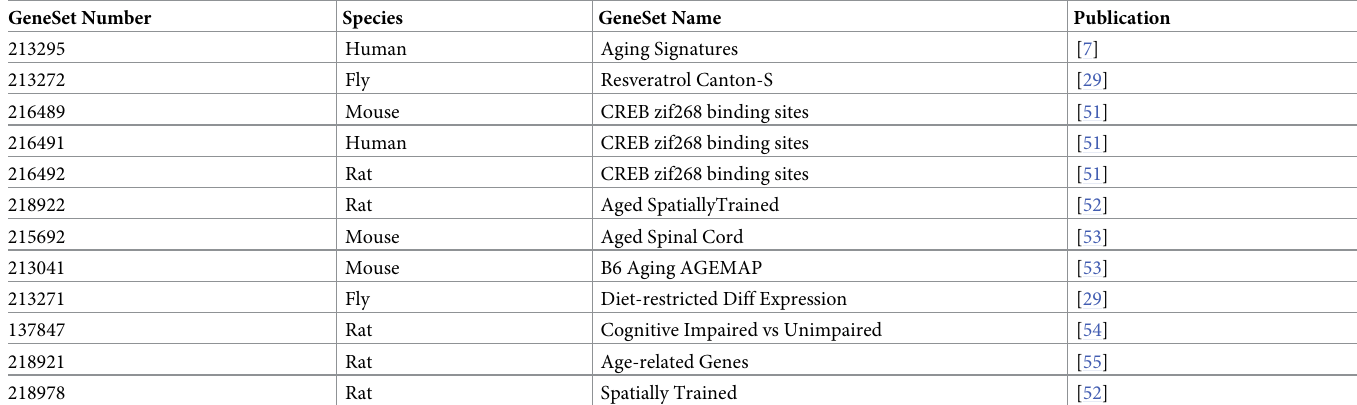
Table 3. The 12, of 73 gene sets that contain Cd63 .